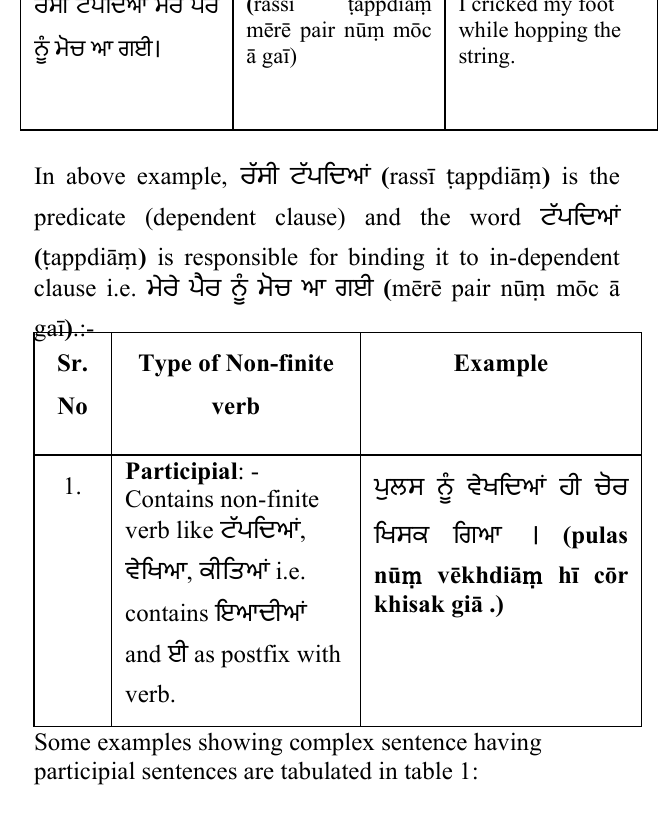
Table 1. Some examples of Participial sentences